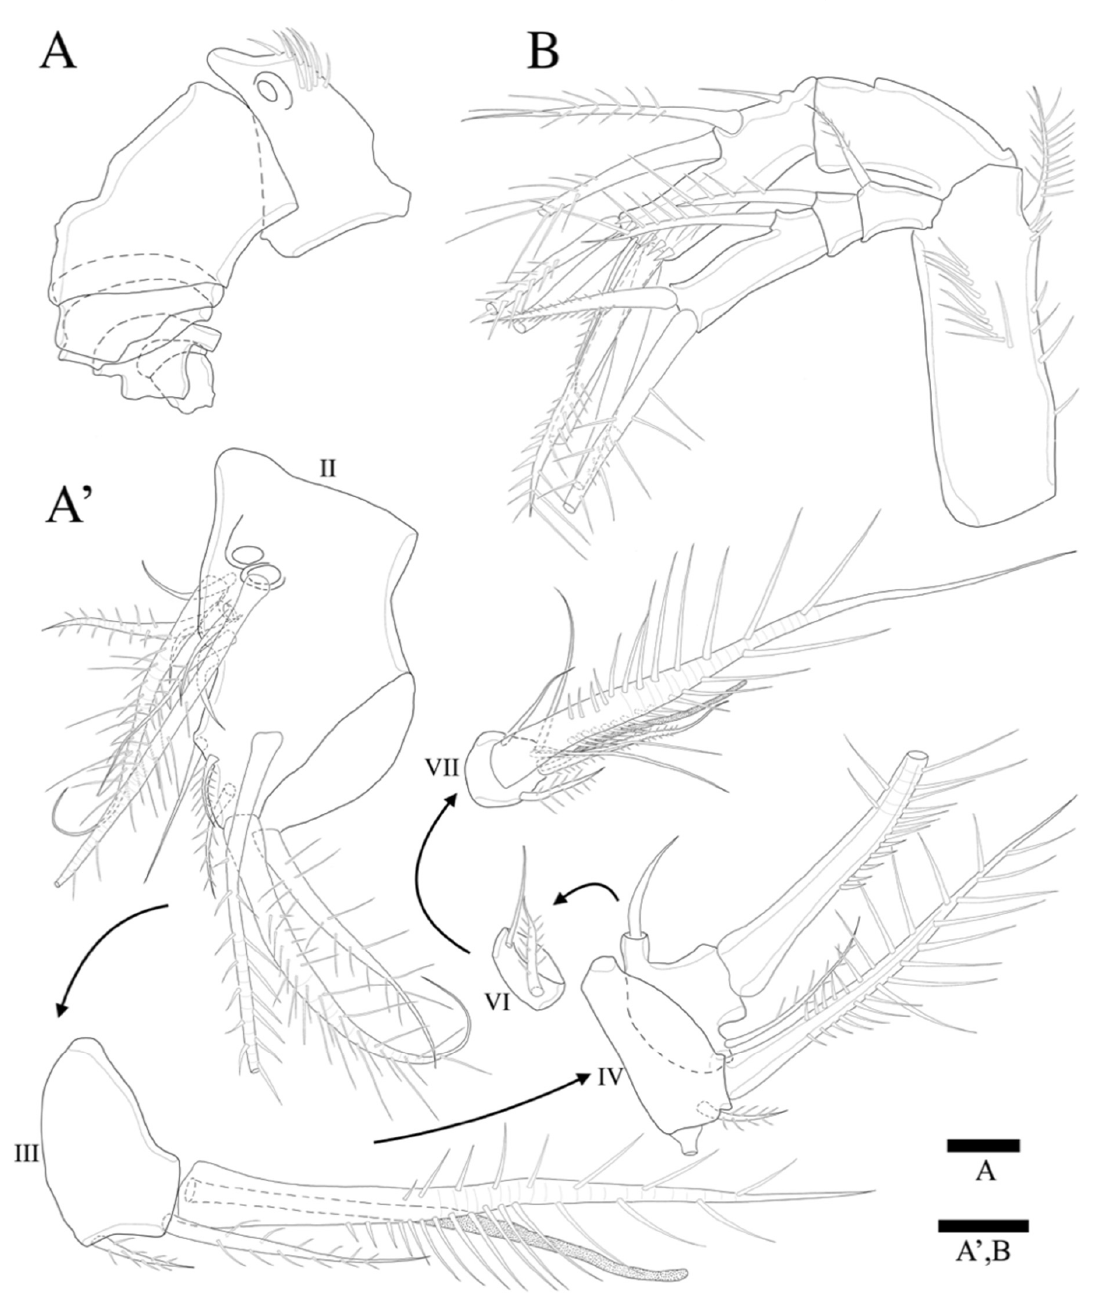
Figure 3. Zosime montagnai sp. nov. Female. ( A ) A1 showing segmentation, armature omitted ( A’ ) A1; ( B ) A2. Scale bars: 10 µm.